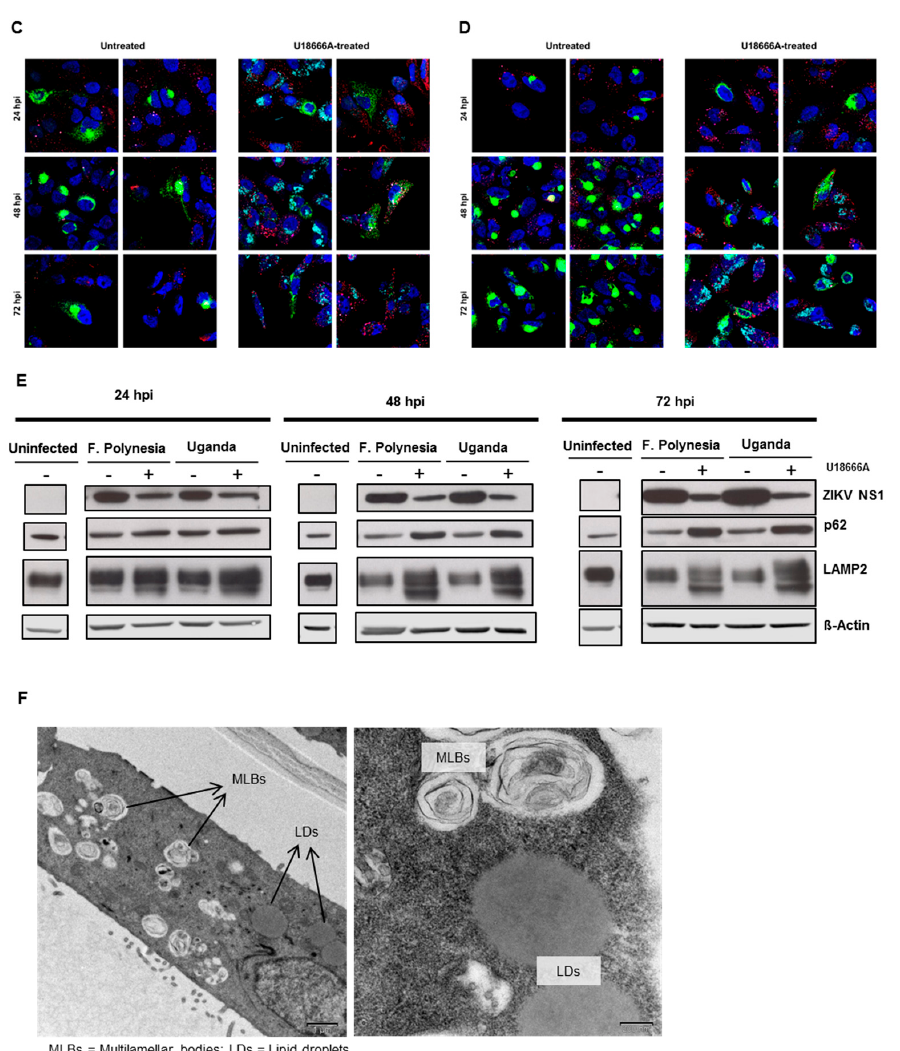
Figure 7. U18666A affects the amount and the intracellular localization of ZIKV proteins in A549 cells. ( A – D ) A549 cells were infected with either the French Polynesia ( A , C ) or the Uganda ( B , D ) strain and treated with 2 µ g / mL of U18666A (post-infection treatment) during the indicated times. Cells were fixed with 4% formaldehyde and analyzed by confocal laser scanning microscopy. Nuclei were visualized with a lamin A-specific antibody (blue), the ZIKV envelope protein with a specific antibody (green), p62 with a specific antibody (red) and free cholesterol with the filipin complex dye (cyan); Pictures were taken with either the 16 × ( A , B ) or 100 × objective ( C , D ); ( E ) A549 cells were infected with either the French Polynesia or the Uganda strain and treated with 2 µ g / mL of U18666A (post-infection treatment). Cell lysates of the indicated times were analyzed by Western blot with specific antibodies against the ZIKV NS1, p62, LAMP2, and β -Actin. The latest was included as loading control; ( F ) Transmission electron microscopy images of U18666A-treated